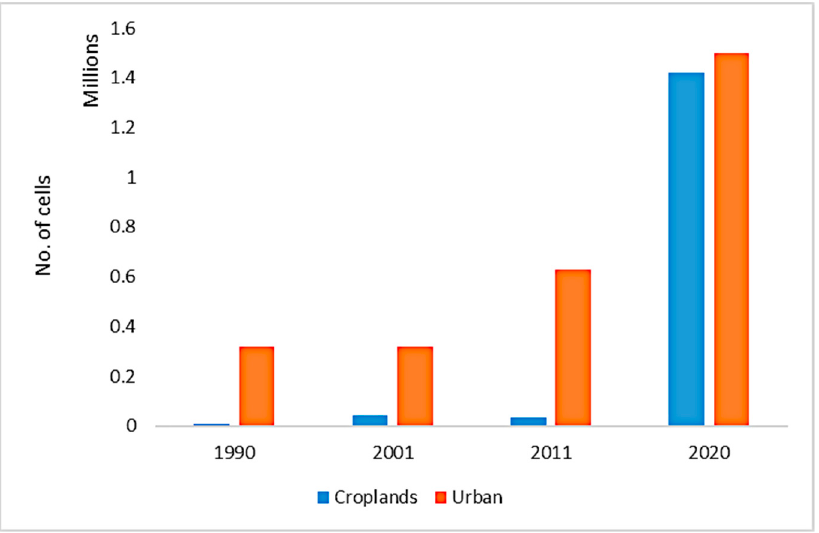
Figure 11. Number of cells for the urban/settlement and croplands land cover classes within the Erdar wells cluster shows increasing areal cover through the years.